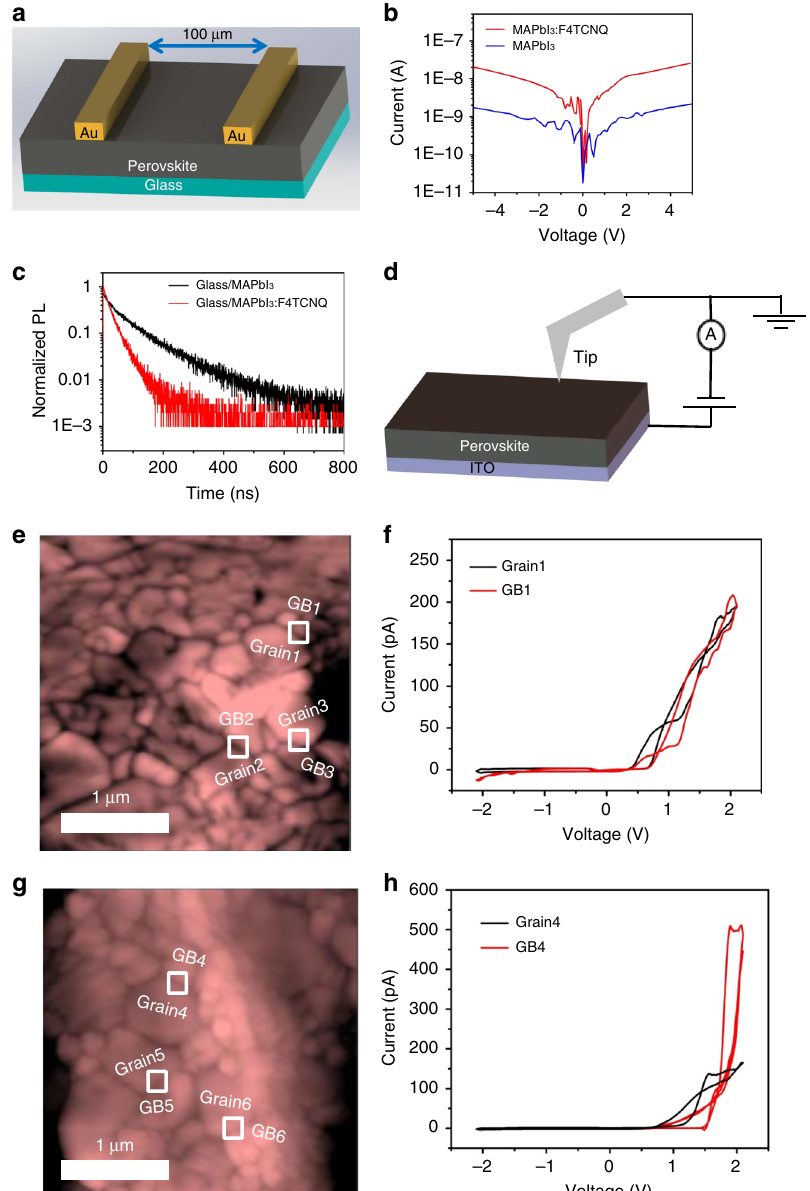
Fig. 2 Conductivities and photoluminescence lifetimes of neat or doped perovskite fi lms. a Geometry for the lateral conductivity measurement: the perovskite fi lms were 500 nm thick, with 1 mm gold (Au) electrodes separated by 100 μ m. b J – V curves of neat or F4TCNQ-doped MAPbI 3 deposited on normal glass substrates, where the current was measured along the lateral direction. c TRPL decay curves of glass/MAPbI 3 and glass/MAPbI 3 :F4TCNQ. PL lifetimes were calculated by single exponential fi tting. d c-AFM setup. Topographic AFM images of e MAPbI 3 and g MAPbI 3 :F4TCNQ fi lms, with locations where the c-AFM tip measured the grain and GB currents. Local dark currents measured at the GBs and on the grains for the f MAPbI 3 fi lm and h MAPbI 3 : F4TCNQ fi (Supplementary Figs. 5, 6 and 7 for SEM images and XRD pat- terns of bladed MAPbI 3 fi lms prepared with different amounts of MHP as well as using co-solvents annealing technique in the absence or presence of MACl) 9,10,16,30,31 . Figure 3a, b show representative SEM images of the bladed perovskite fi lms after optimization, which featured a uniform morphology that exten- ded hundreds of micrometers. The perovskite domains were densely packed together, and without observable voids at domain boundaries (Fig. 3a). It should be noted that these domains are not single crystalline grains. Each micrometer-scale convection domain was comprised of micro-sized grains ranging from 800 to 1700 nm (average above 1 μ m, Fig. 3b).